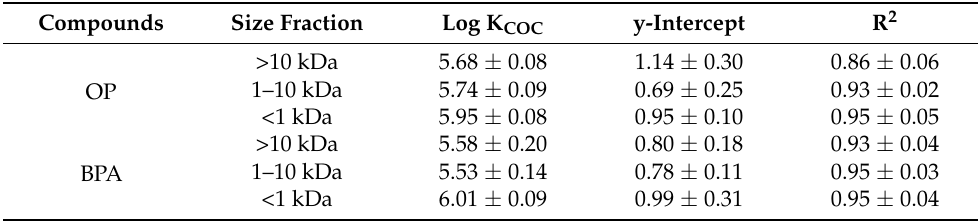
Table 2. Summary of linear regression between octylphenol (OP) and bisphenol A (BPA) and size- fractioned DOM using the fluorescence static quenching